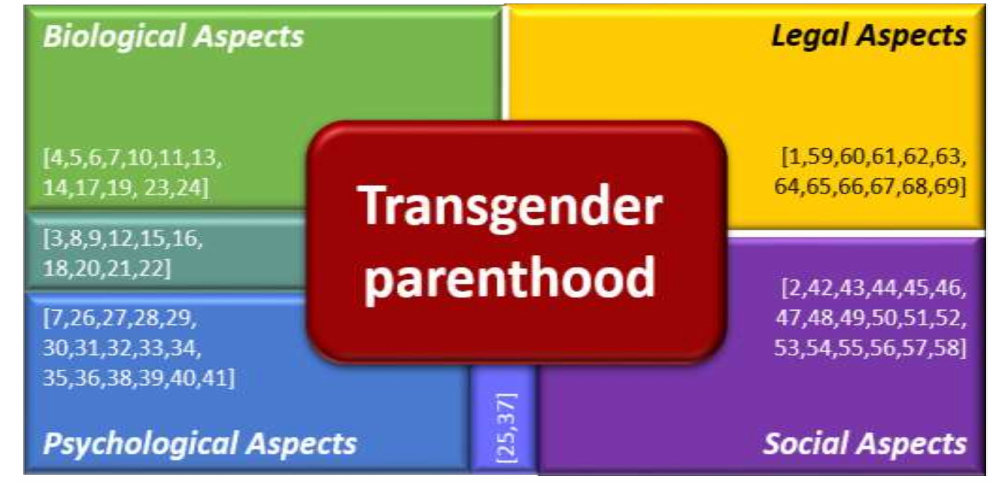
Figure 2. The analysis of the data revealed four broad